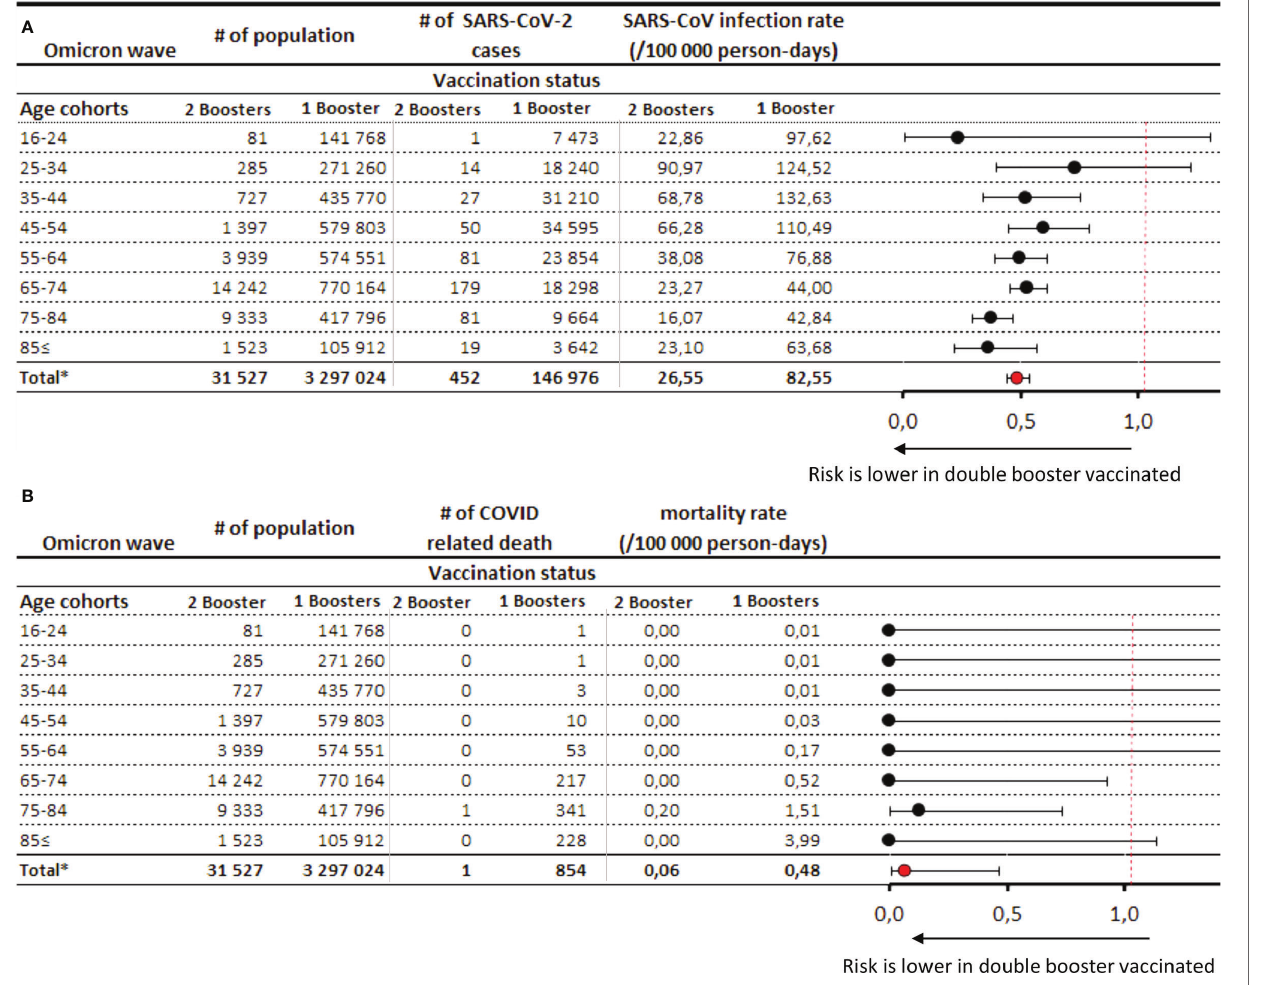
FIGURE 4 | SARS-CoV-2 infection rates (A) and Covid-19 related mortality (B) during the Omicron wave in the double vs. single booster vaccinated population. *Exact con fi dence intervals for age-speci fi c mortality rate ratios and Mantel-Haenszel pooled mortality rate ratio for the total population adjusted for